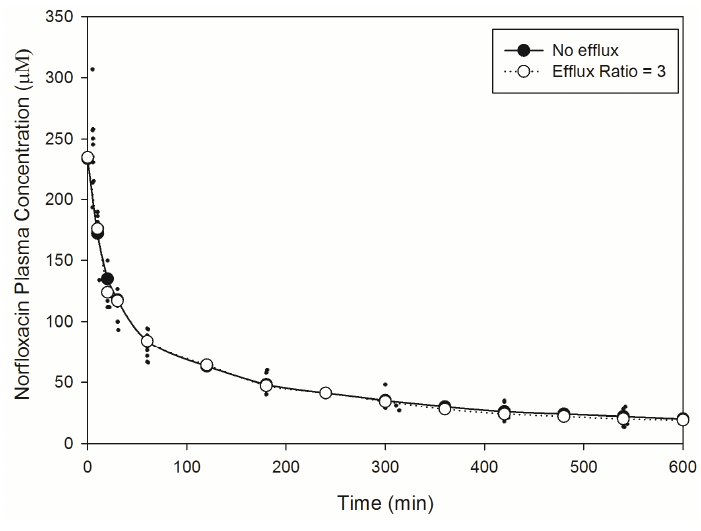
Figure 2. Model predicted norfloxacin plasma concentrations in rats. Small closed circles represent literature reported plasma concentrations determined in rats following an IV-bolus dose [88]. Large closed circles represent model predicted norfloxacin plasma concentrations in rats in the absence of efflux. Large open circles represent model predicted norfloxacin plasma concentrations in rats in the presence of efflux (efflux ratio =